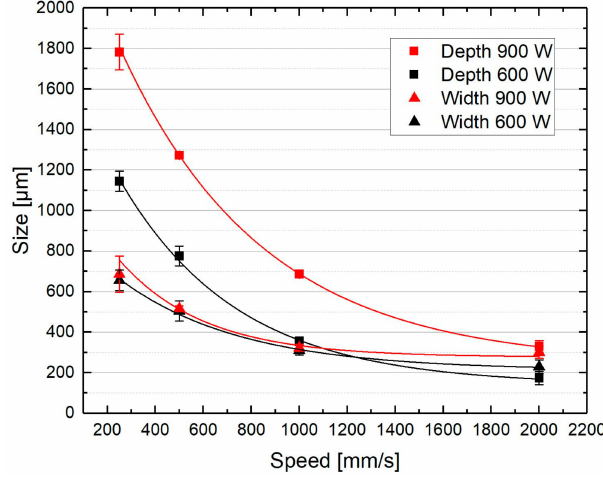
Figure 5. Melt pool dimensions for single parameter variation using secondary laser tracks .